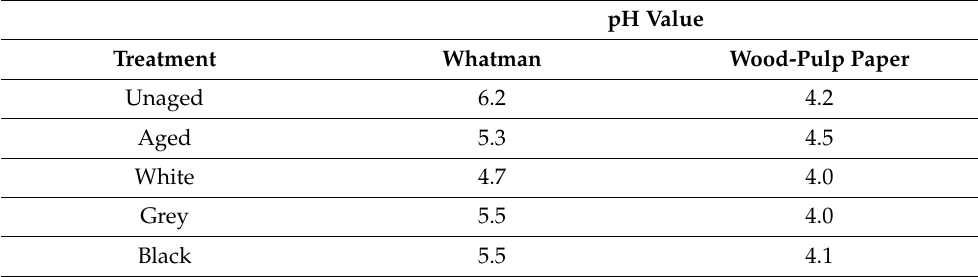
Table 4. Cold extract pH value for tested types of